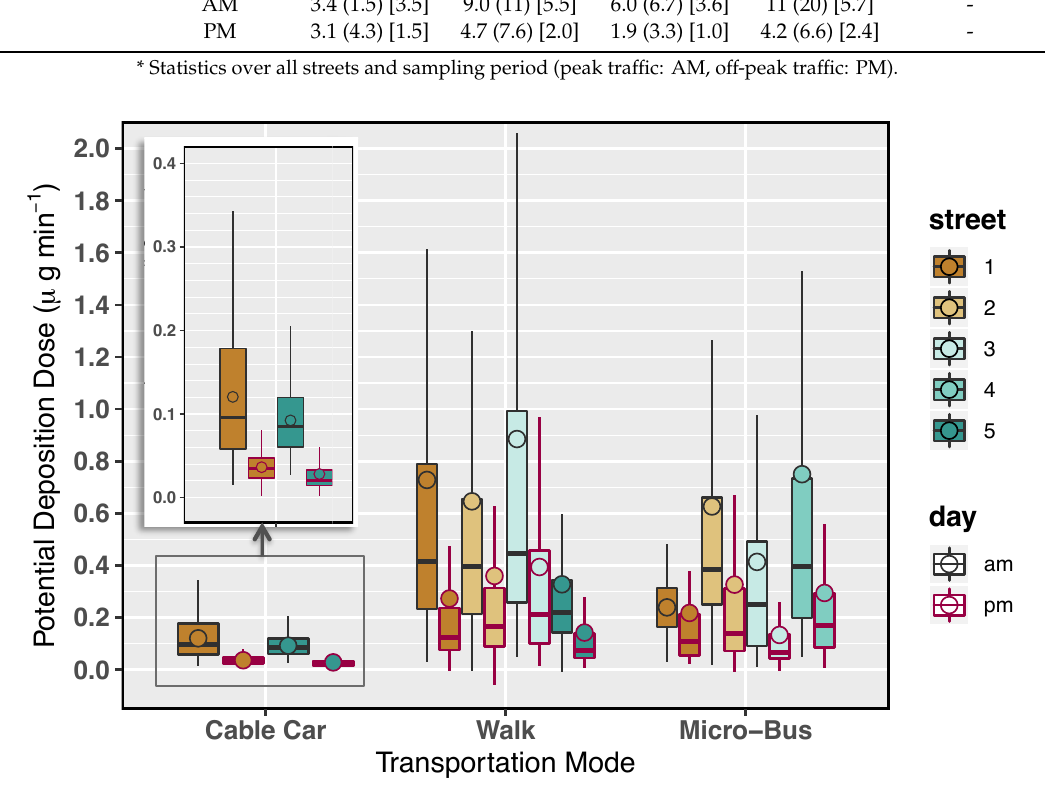
Figure 3. Normalized eBC RDD in di ff erent TMEs along di ff erent routes at di ff erent sampling times. Box plots with medians are shown in the figure, where the box corresponds to the 25–75th percentiles and circles represent mean